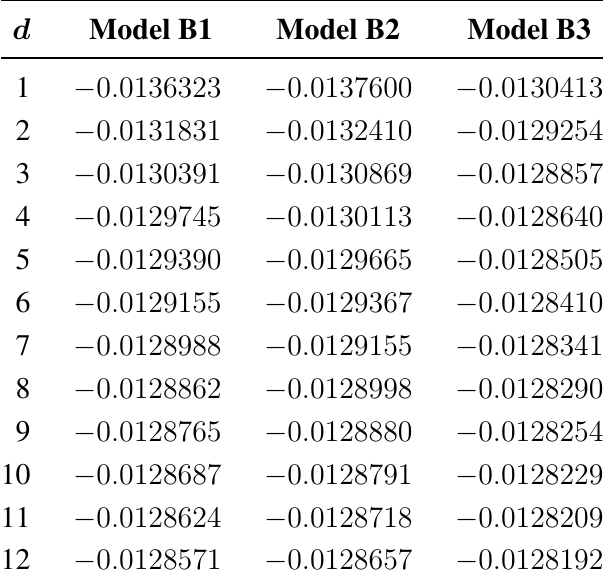
Table 7. The value (to Player) of baccara chemin de fer as a function of the number of decks d under Models B1, B2, and B3, rounded to six significant digits. The values under Models 0 . 0127991 A1, A2, and A3 are all equal to